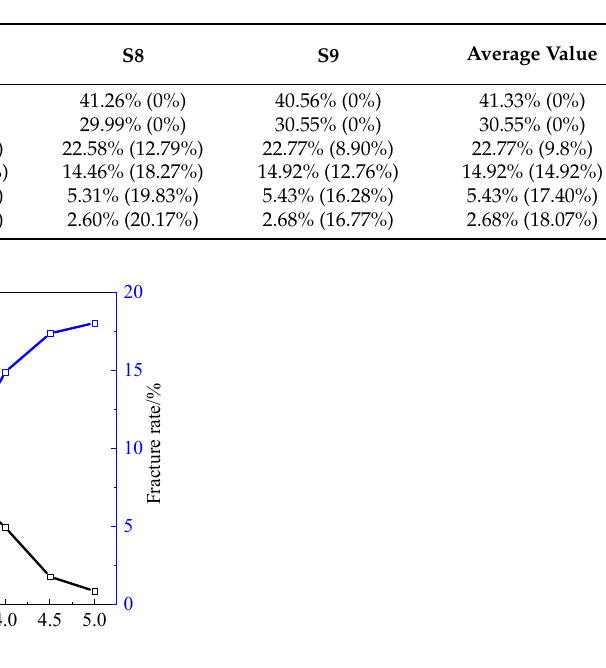
Figure 12. Comparison curves of moisture content and fissure rate of soil samples of two thicknesses.